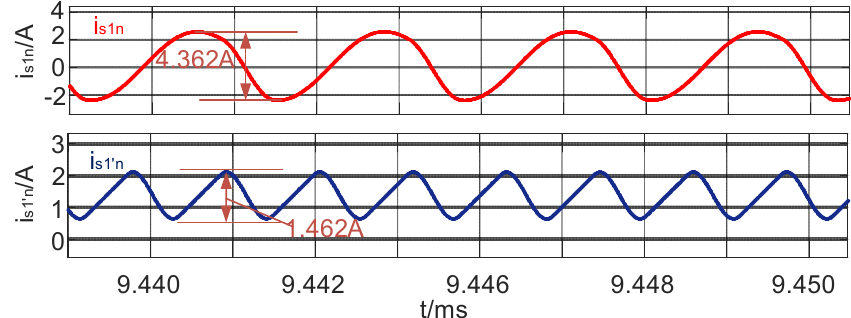
Figure 17. IDC static 180° phase-shifting input current waveform .